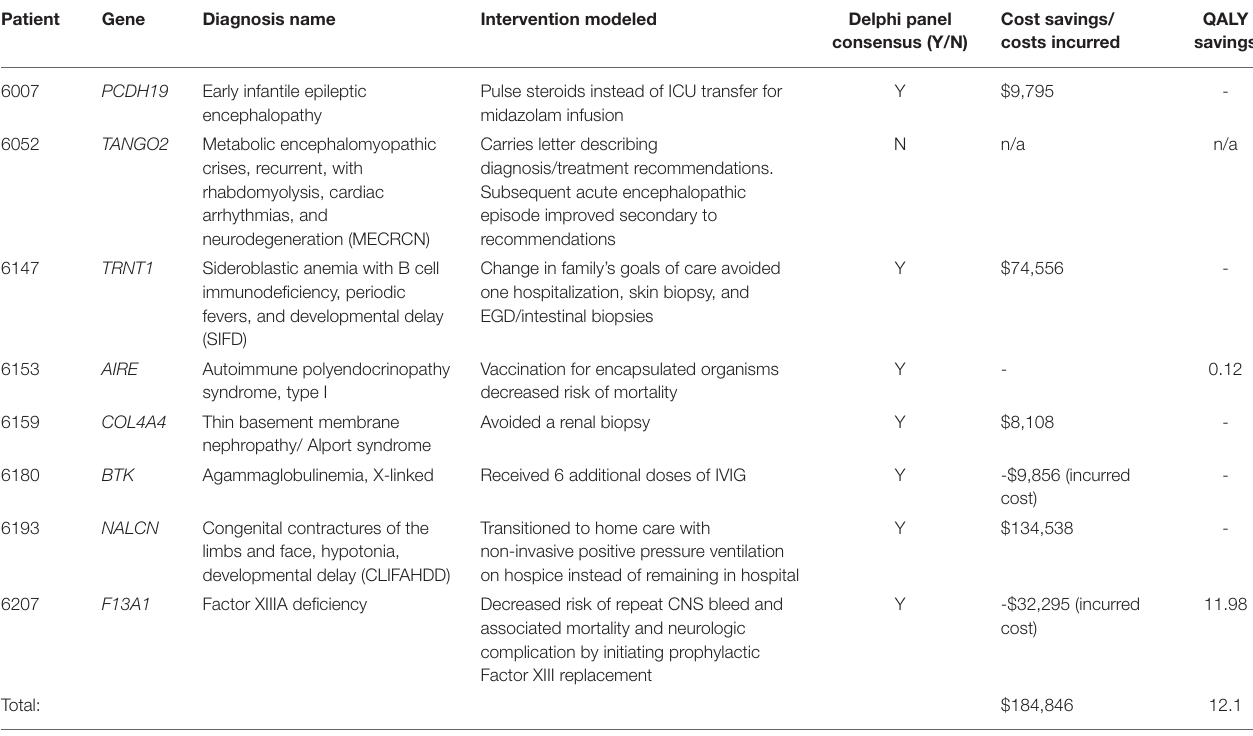
TABLE 1 | Precision medicine interventions in eight of 13 patients who received molecular diagnoses and had resultant changes in clinical care.